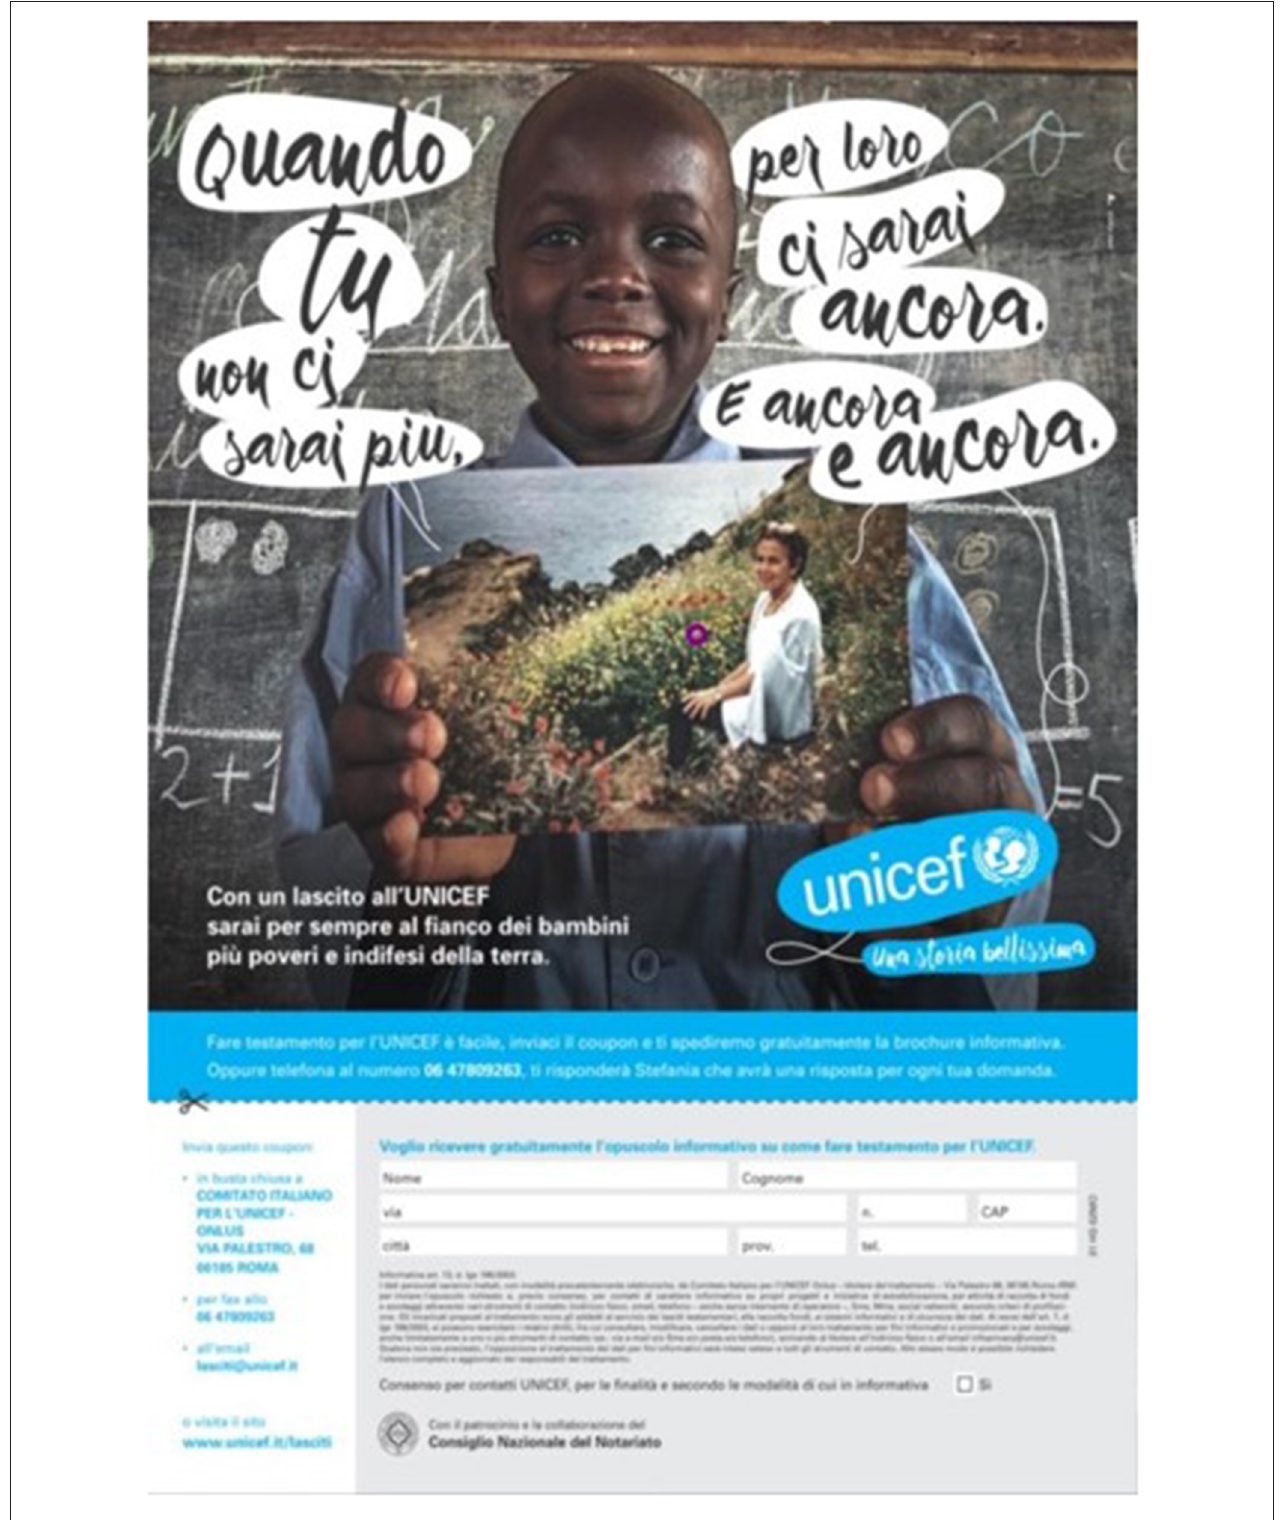
FIGURE 3 | Unicef Flyer A. Source: Ambrogetti (2019, p.